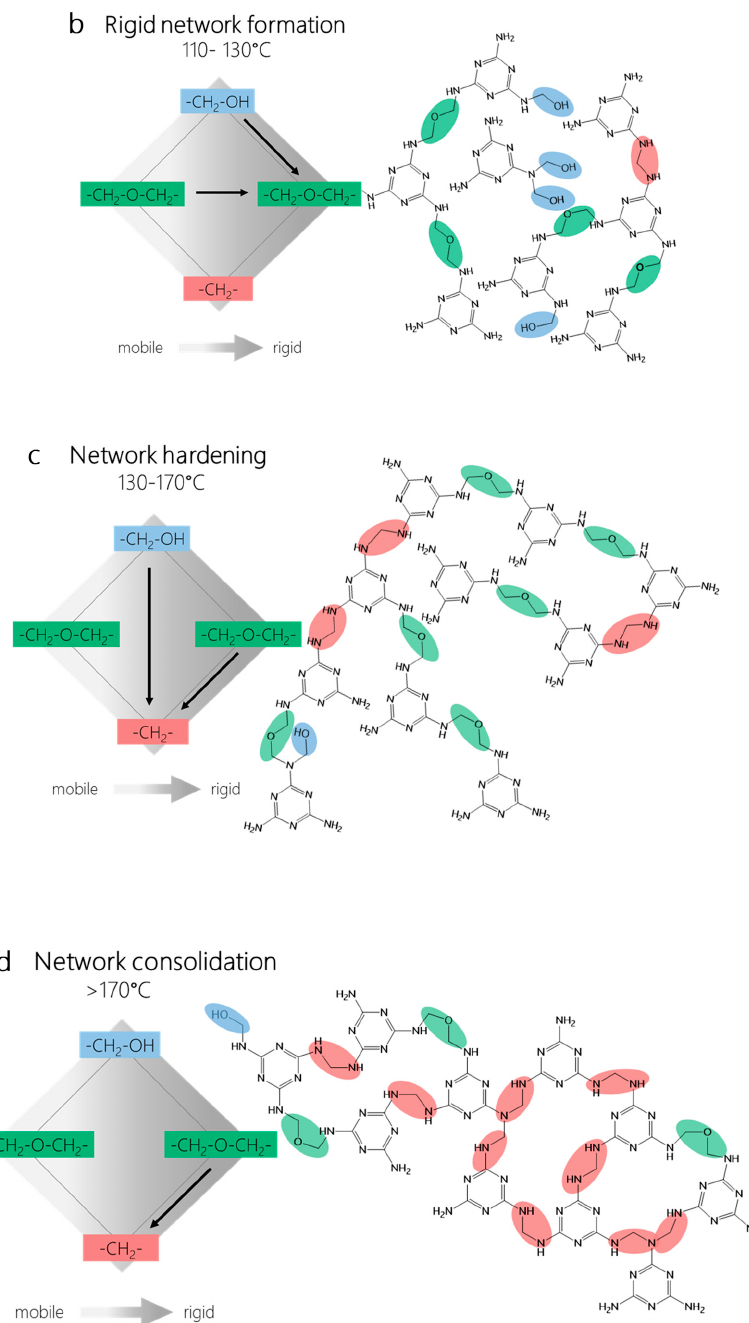
Figure 8. The phases of solid MF resin cure during which the major chemical transformations take place. ( a ) Flexible network formation, taking place in a temperature range between 60 and 110 ◦ C; ( b ) Rigid network formation, taking place in a temperature range between 110 and 130 ◦ C, ( c ) Network hardening, taking place in a temperature range between 130 and 170 ◦ C; and ( d ) Network consolidation, taking place in a temperature range higher than 170 ◦ C. The color gradient from light to dark grey in the diamond from left to right indicates the increasingly solidifying network. The black arrow in ( b ) between the ether bridges indicates no chemical transformation but the transition of a rather mobile, ether-dominated into a rather rigid ether-dominated network structure via network stratification. In other words, the transition from a multitude of interpenetrating network fragments into a more homogenous, cross-linked larger network of greater